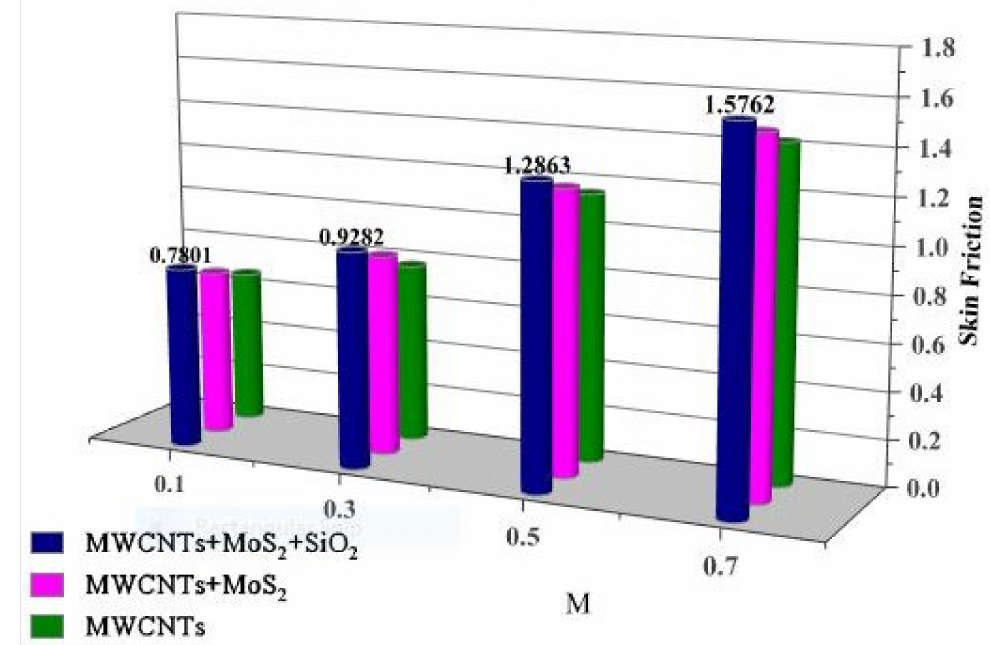
Figure 10. Drag force vs. M